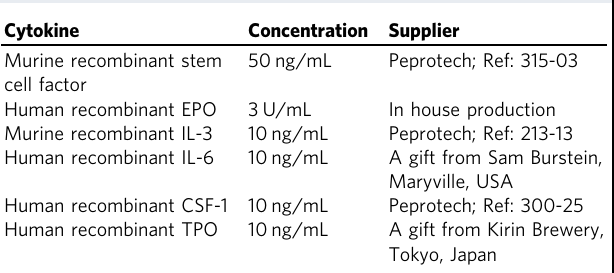
Table 1 Breeding crosses used throughout this study. Table 2 Cytokines used in this